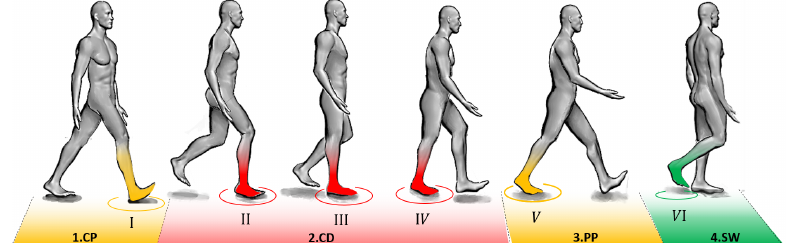
Figure 2. Sub-phases and states during the gait cycle used to obtain the ankle behavior in the level-ground